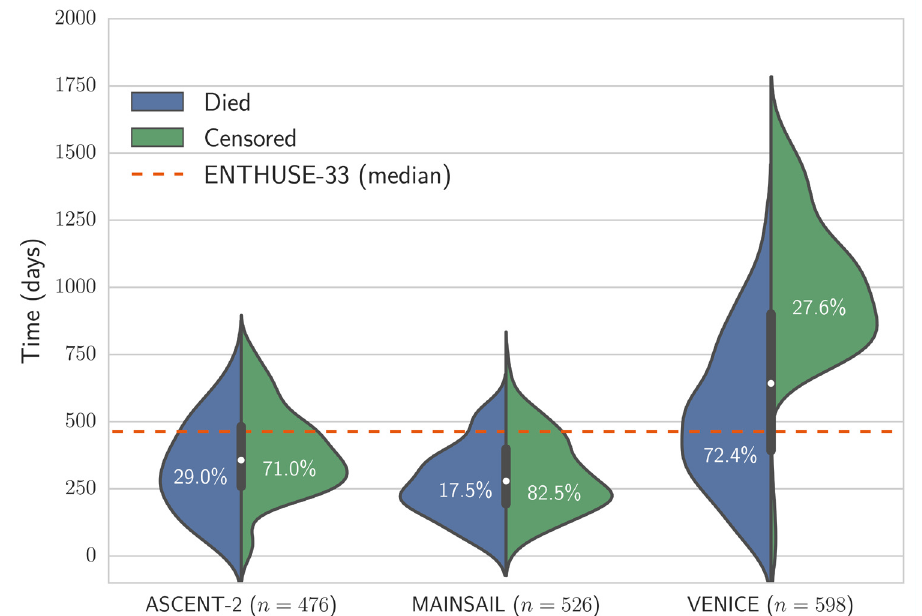
Figure 1. Overview of distribution of survival and censoring times in training data from the ASCENT-2, VENICE, MAINSAIL, and ENTHUSE-33 trial 22–25 . Numbers in brackets denote the total number of patients in the respective trial, and the dashed line is the median follow-up time in the ENTHUSE-33 trial, which was used as independent test data.